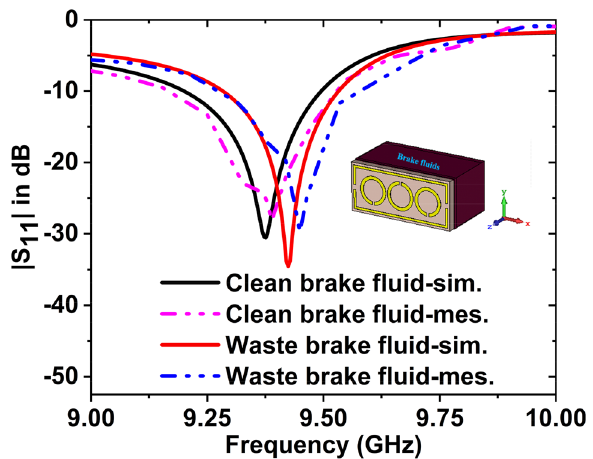
Figure 23. S 11 result for the waste and clean brake